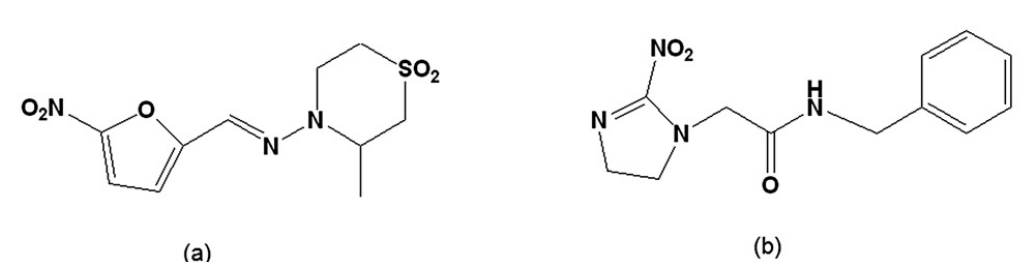
Figure 2. (a) Tetrahydro-3-methyl-4-[(5-nitrofurfurylidene)amino-2 H -1,4-thiazine